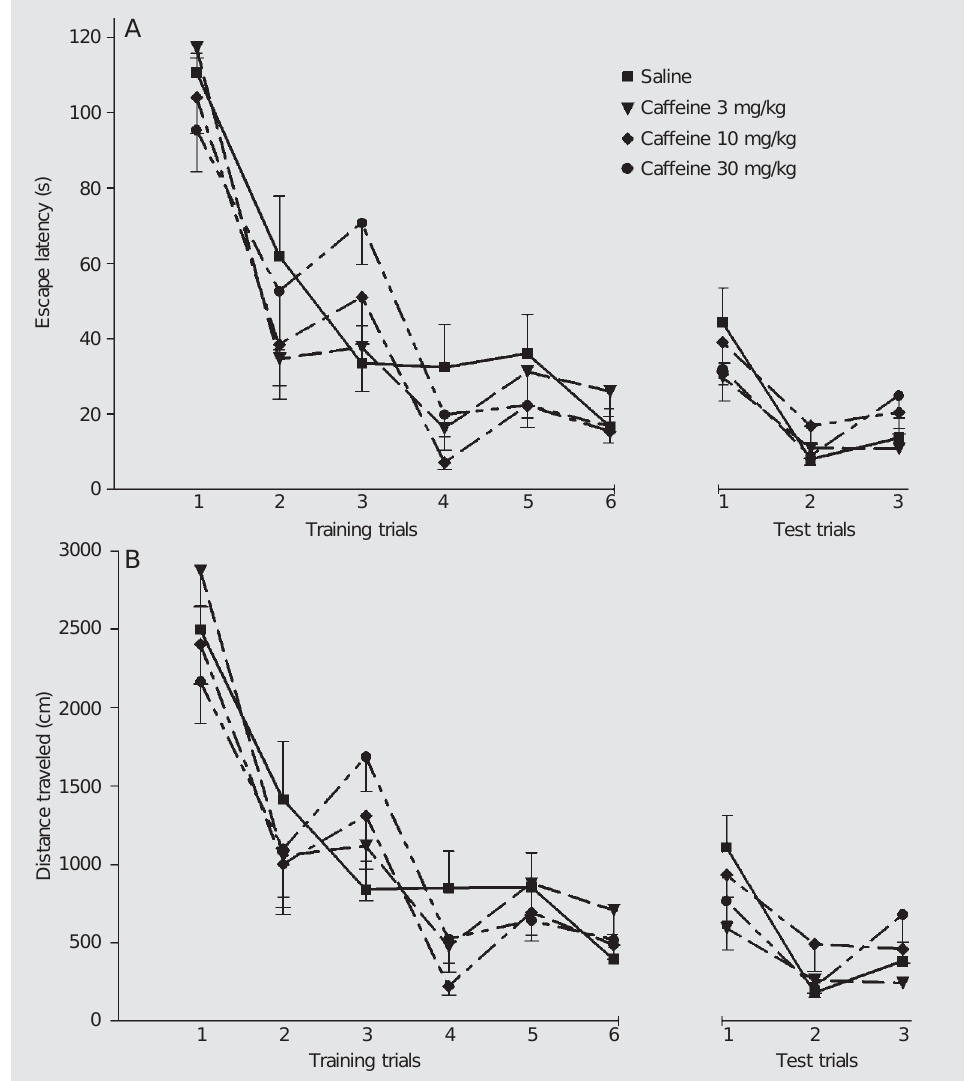
Figure 4. Effect of the adminis- tration of caffeine 30 min before the test session on the learning of the Morris water maze